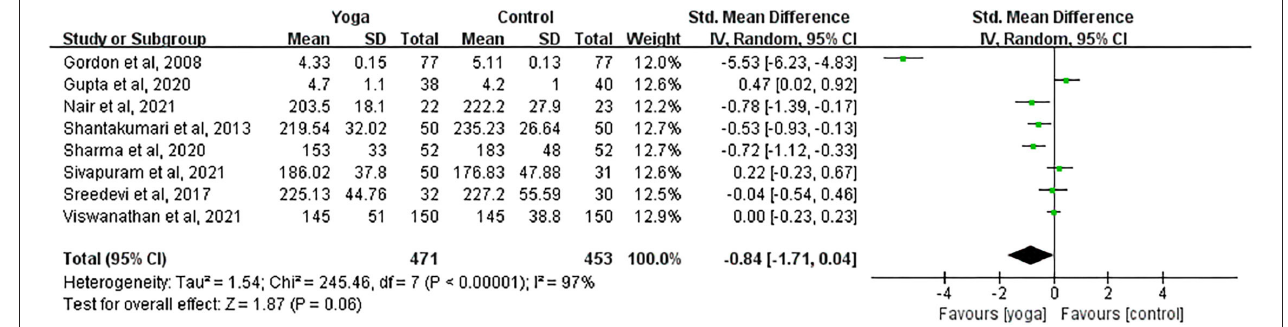
FIGURE 7 | Forest plots of the effect of yoga on TC.